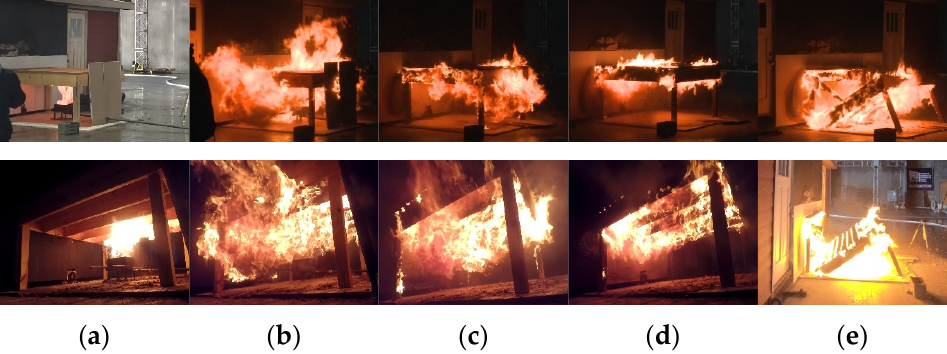
Figure 15. Time-lapse of a redwood deck with Southern Yellow Pine joists test from two angles. ( a ) After 5 s. ( b ) After 3 min. ( c ) After 5 min. ( d ) After 7 min. ( e ) After 10 min.